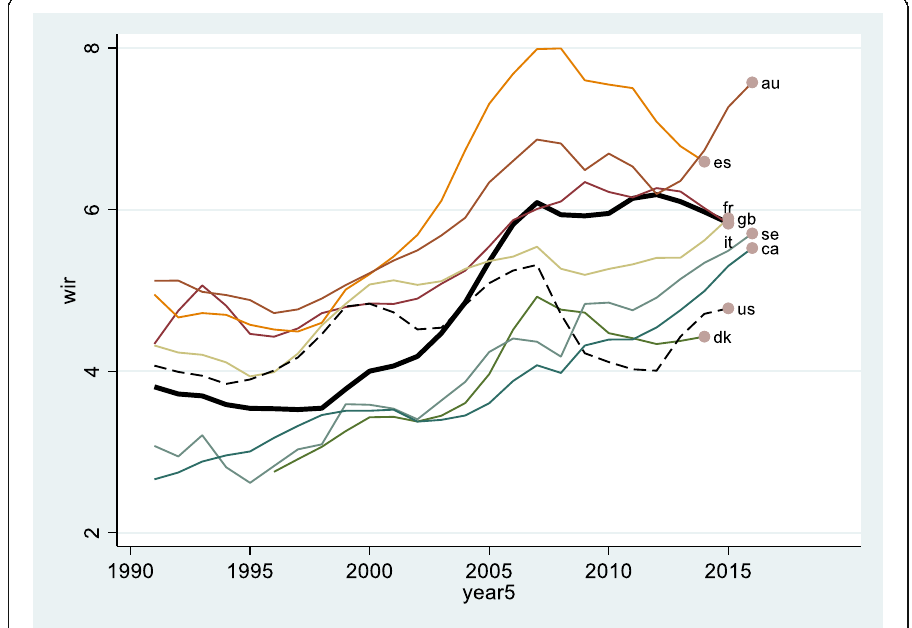
Fig. 1 Wealth-to-income ratio in nine Western countries (France: as reference line in bold). Note: Country codes refer respectively to au Australia, ca Canada, dk Denmark, es Spain, fr France, gb Great Britain, it Italy, se Sweden, and us the United States. Source: Authors ’ calculations based on the WID, https://wid.world/, see Alvaredo et al.